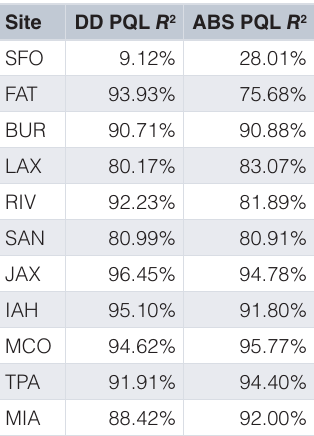
Table 2. Percentage of PQL variance captured by the mean of the normal. DD PQL is the 3 generation single sine degree day based prediction, and ABS PQL is the MED-FOES agent-based simulation